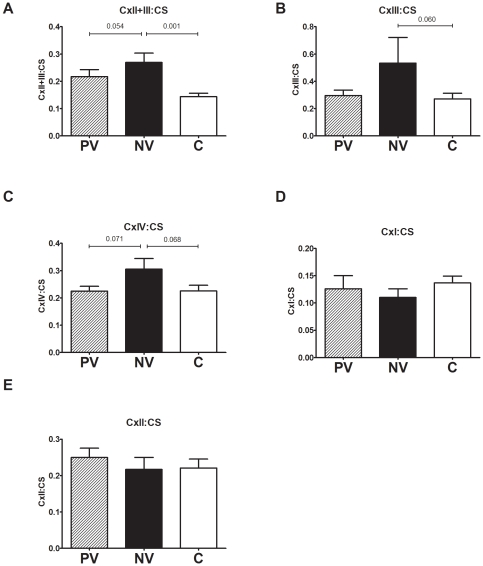
Oxidative phosphorylation complex activities are increased in normal vision patients.Lymphoblast mitochondria were used to determine the specific activity of OXPHOS enzymes. A) cytochrome c reduction at 550 for complex II+III linked assay, B) cytochrome c reduction at 550 for complex III, C) oxidation of ferrocytochrome c at 550 nm for complex IV, D) NADH oxidation at 340 nm for complex I and E) DCIP reduction at 600 nm for complex II. The data was normalised to the citrate synthase activity of each mitochondrial sample. Data are average +/− SEM. (P) poor vision (n = 8), (N) normal vision (n = 7), (C) controls (n = 21) for 3 independent experiments. There was a significant increase in the complex II+III activity in normal vision ADOA, with trends of increased complex III and IV when compared to poor vision ADOA.